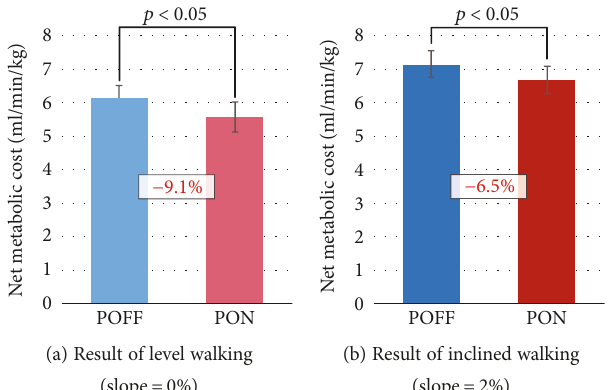
Figure 7: Comparisons of two-day average value of metabolic cost between the POFF condition and the PON condition for 15-minute level walking and 15-minute inclined walking. On each bar chart, the error bar denotes standard deviation. In addition, the number expressed in percentage represents the di ff erence of the PON condition compared with the POFF condition.